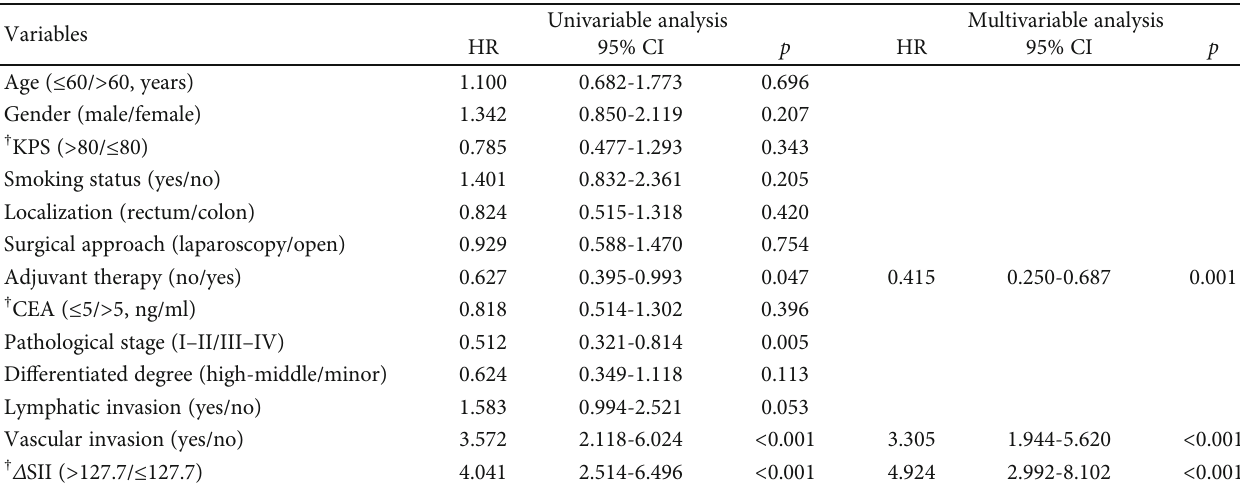
Table 4: Univariable and multivariable analysis for disease-free